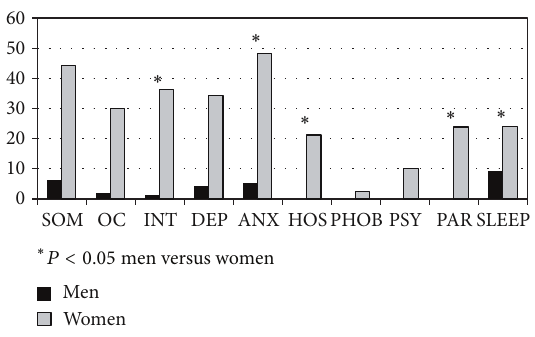
Figure 3: Percentages of pathological SLC-90 subscale scores in celiac disease women and men. ∗ indicate subscales with statistically significant differences ( 𝑃 < 0.05 ) between the two sexes (Student’s 𝑡 -test for unpaired